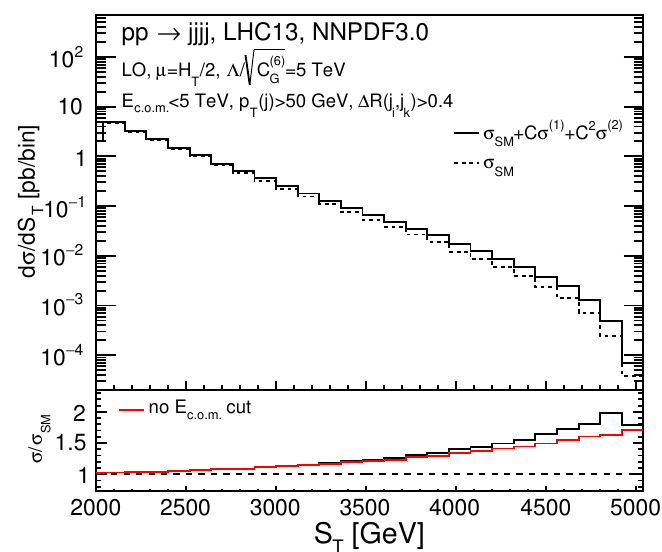
Figure 5 . Distribution of S T and corresponding deviation from the SM after applying a cut on the partonic centre of mass energy of the events, E c.o.m. < 5